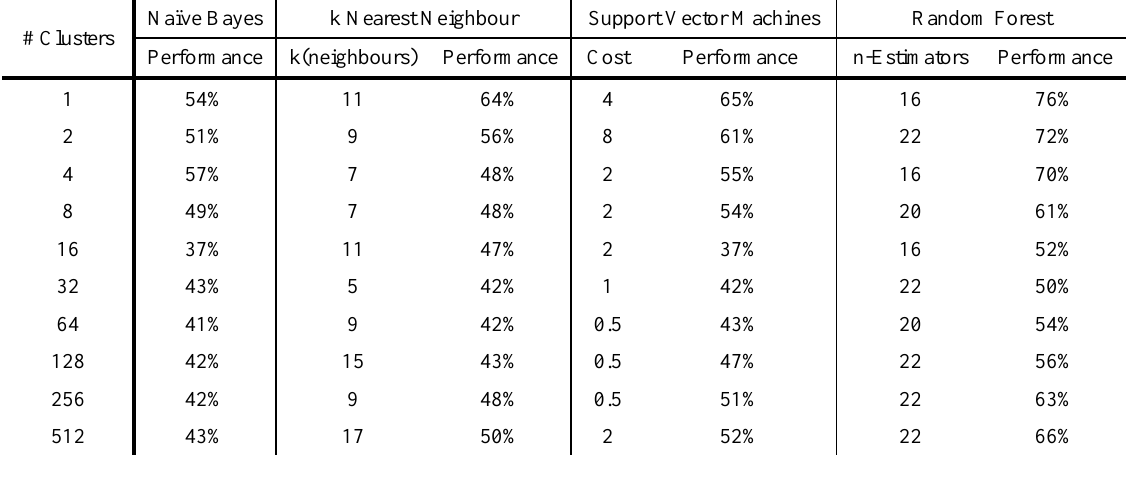
Table 5. Accuracies for best performing parameter for each MLA and number of clusters from the cross validation. Best performance among clusters with corresponding parameter value for each MLA is highlighted in red. identified (black) data points. Clusters are in both images as lightly coloured groups of data points. Refer to Figure 2 and Table 4 for validation map and legend. These images show that as the number of calibration clusters increases, (1) major structural and lithological trends, or contacts, become more distinct, and that (2) correct identification of rocktypes increases with a greater number of calibration clusters and